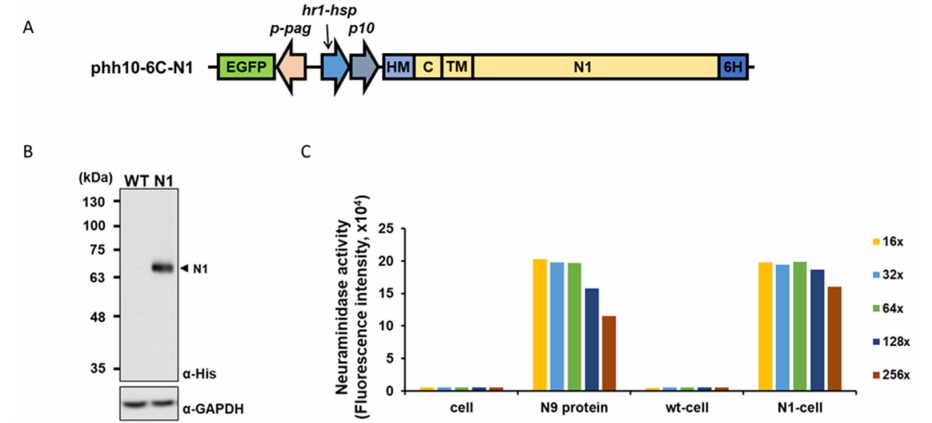
Figure 1. Construction and characterization of recombinant baculovirus N1-Bac. ( A ) Baculovirus expression construct for N1-Bac (phh10-6C-N1). EGFP, green fluorescent reporter; p-pag , pag promoter; hr1-hsp70 and p10 , a dual promoter for N1 expression; HM, honeybee melittin signal peptide; C, cyto- plasmic tailed domain; TM, transmembrane domain; N1, N1 ectodomain; 6H, a hexameric histidine tag. ( B ) Western blot analysis of insect cells infected with wt-Bac and cells infected by N1-Bac. N1 was detected with an anti-His antibody. ( C ) NA activities of insect cells only (cell), purified N9 protein, insect cells infected with wt-Bac (wt-cell), and cells infected with N1-Bac (N1-cell) were detected using a fluorescence-based NA activity assay. Colors represent serial two-fold dilution factors.